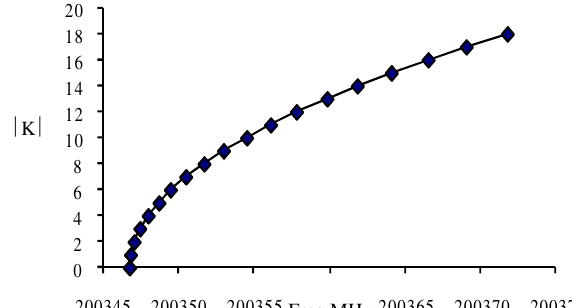
O) in ground state for J = 18. 2 3